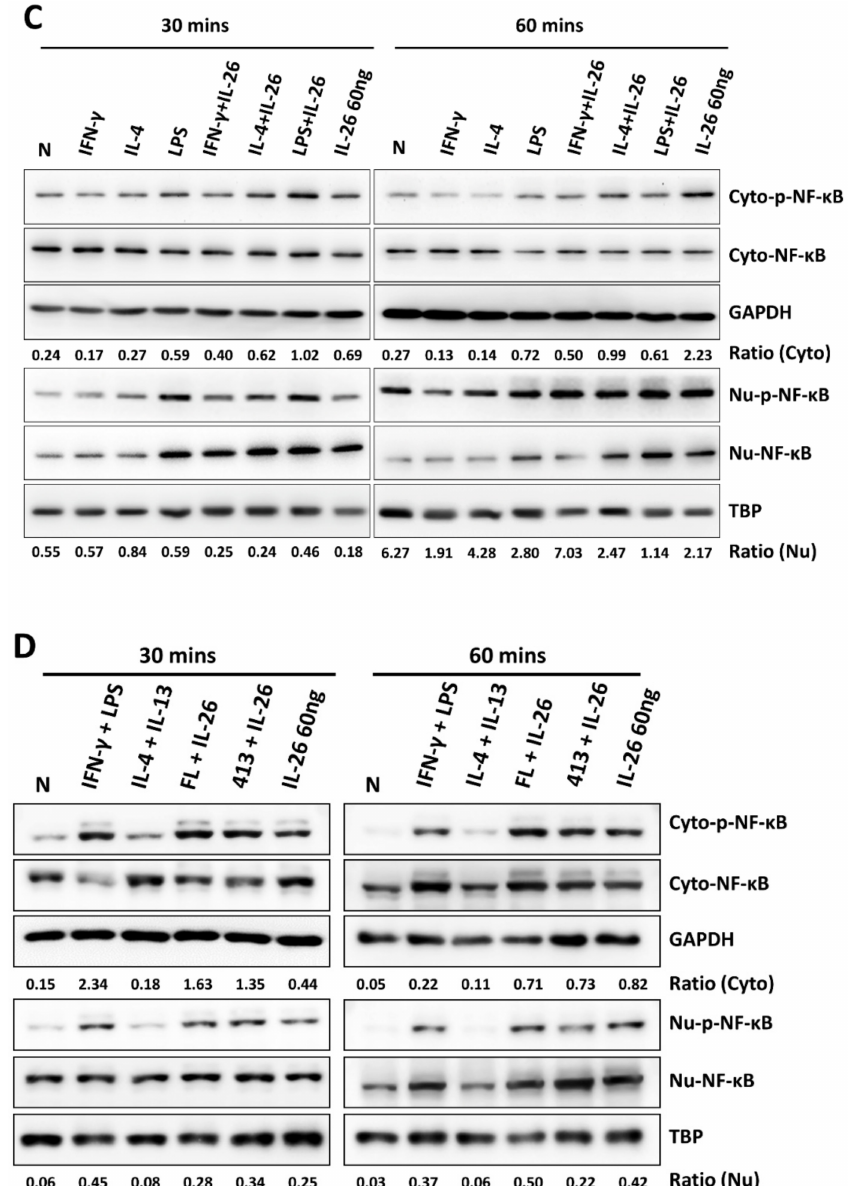
Figure 5. E ff ect of IL-26 on cJUN and NF- κ B activation in M1 and M2 macrophage di ff erentiation. ( A , C ) RAW264.7 cells were serum-starved for 16 h and then treated with IFN- γ (20 ng / mL), IL-4 (20 ng / mL), or LPS (10 ng / mL) in the presence or absence of IL-26 for 30 or 60 min. ( B , D ) THP-1 cells were treated with IFN- γ (20 ng / mL) plus LPS (10 ng / mL) or IL-4 (20 ng / mL) plus IL-13 (20 ng / mL) in the presence or absence of IL-26 for 30 or 60 min. Cytoplasmic extracts (Cyto) and nuclear extracts (Nu) were analyzed by western blot using an antibody specifically directed against phosphorylated or non-phosphorylated c-JUN ( A , B ) and NF- κ B ( C , D ) proteins. Equal amounts of protein were loaded in each lane as demonstrated by the level of TBP, nuclear internal control, and GAPDH, cytoplasmic internal control. A representative result of at least three independent experiments is shown. (FL + IL-26: IFN- γ + LPS + IL-26; 413 + IL-26: IL-4 + IL-13 +